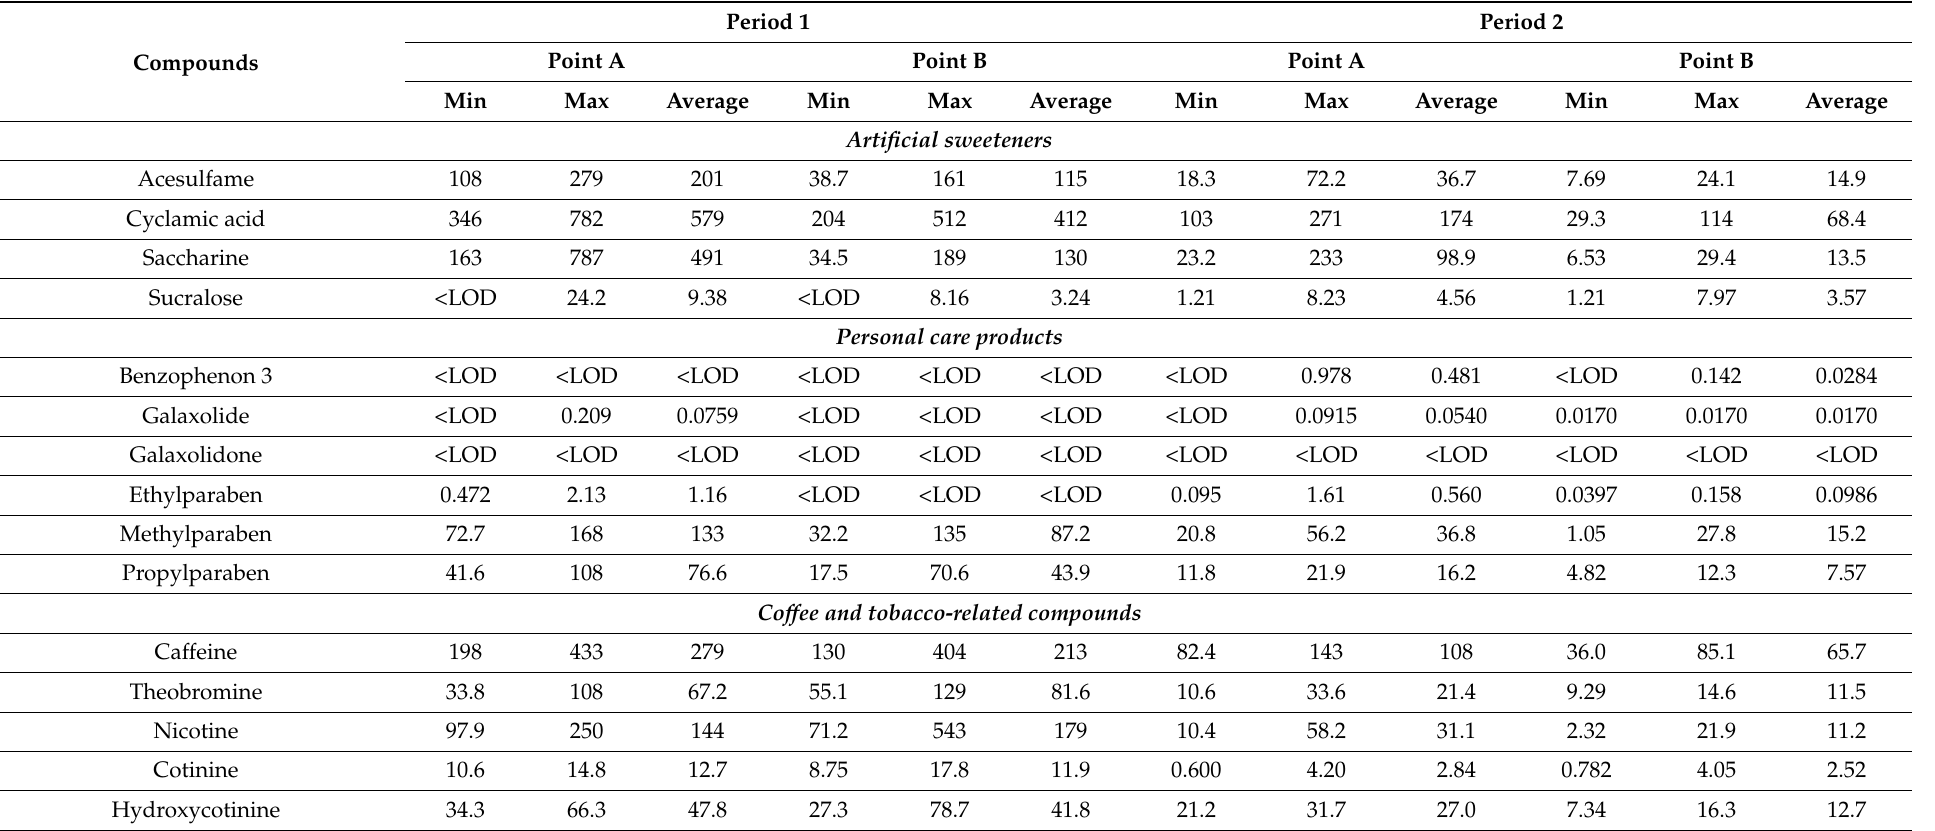
Table 2. Minimum, maximum, and average concentrations ( µ g/L) of detected emerging contaminants in the HWW at both sampling sites and